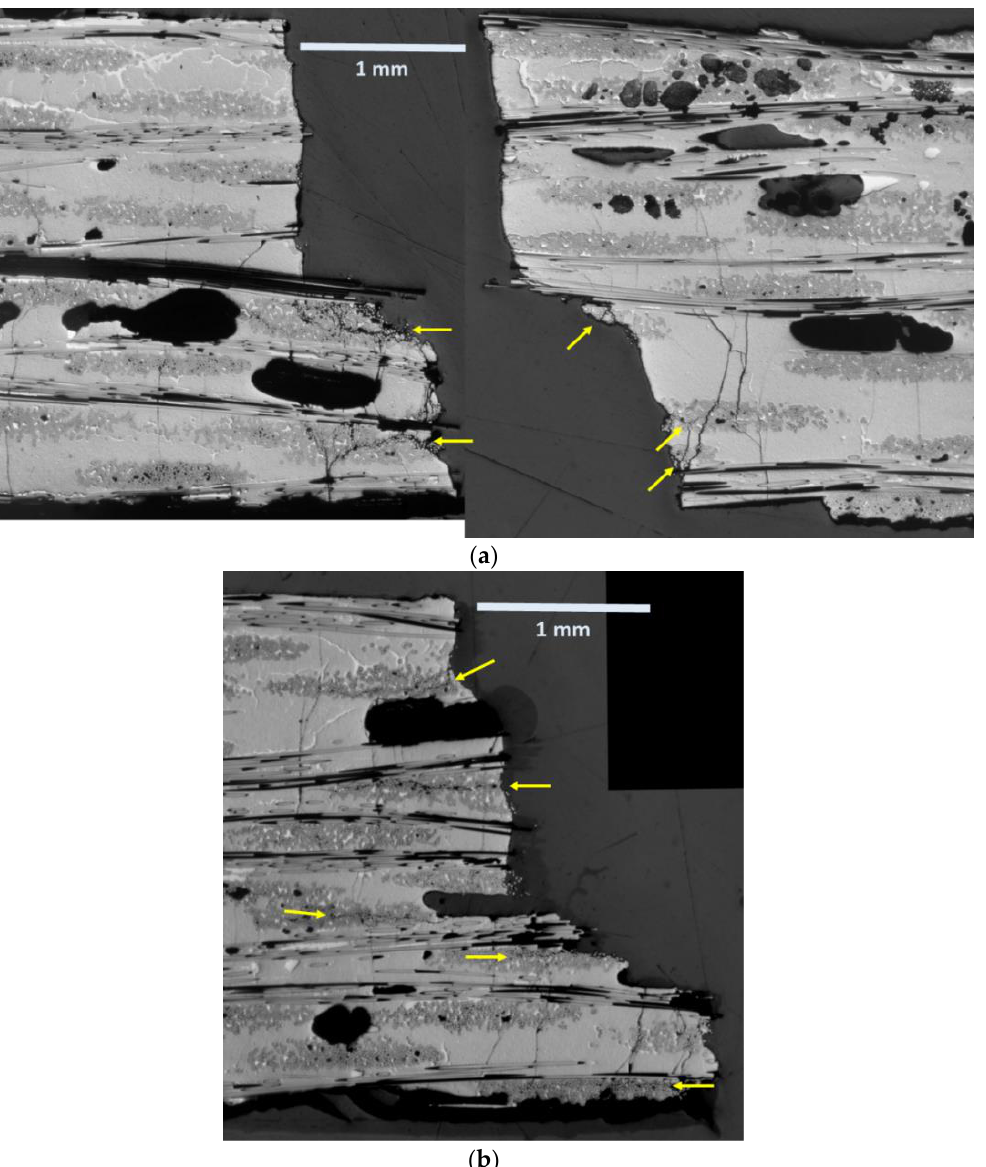
Figure 12. Polished longitudinal sections of 147-3: ( a ) both sides of the fracture surface approximately 1 mm from the edge; and ( b ) the left side of the fracture surface approximately 3.5 mm from the edge of the specimen. Arrows indicate some of the longitudinal and diagonal cracking in the 90 tows.